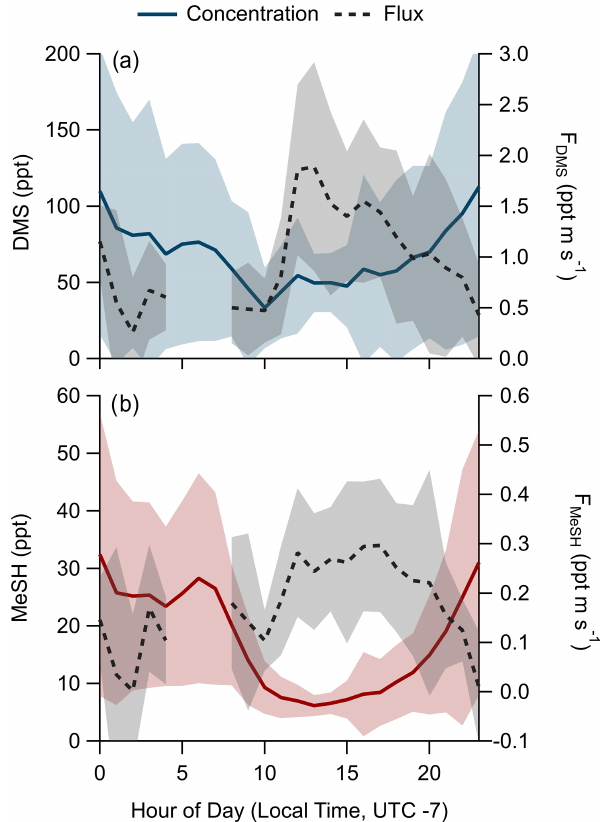
Figure 4. Hourly averaged diel profiles of observed mixing ratios and eddy covariance flux of (a) DMS and (b) MeSH. Shading rep- resents the standard deviation of the binned hourly means. Winds were primarily from the land for hours 00:00–10:00, limiting air– sea flux measurement during those